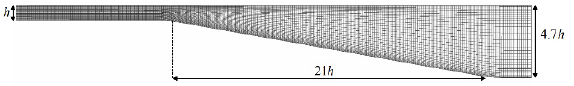
Figure 8. Computational mesh for the plane diffuser with 20,000 cella.